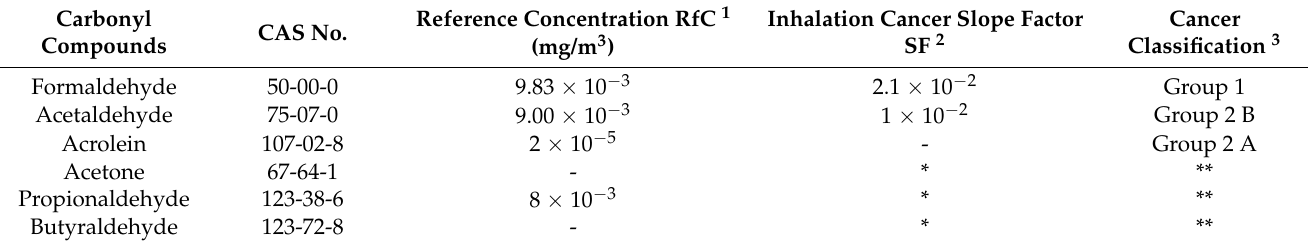
Table 2. Toxicological profiles and parameters for carbonyl compounds.